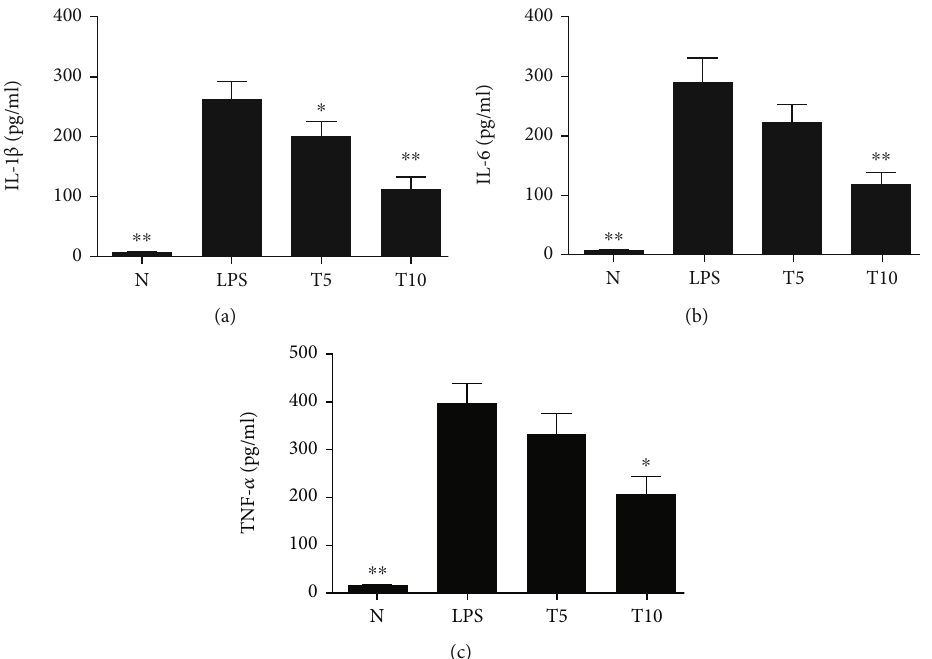
Figure 9: Tomatidine modulated serum cytokine levels, including (a) IL-1 β , (b) IL-6, and (c) TNF- α , in ALI mice. Data are presented as the mean ± SEM . ∗ p < 0 : 05 and ∗∗ p < 0 : 01 vs. LPS group. N group: normal control mice; LPS group: LPS treatment only; T5 group: 5 mg/kg tomatidine plus LPS; T10 group: 10 mg/kg tomatidine plus